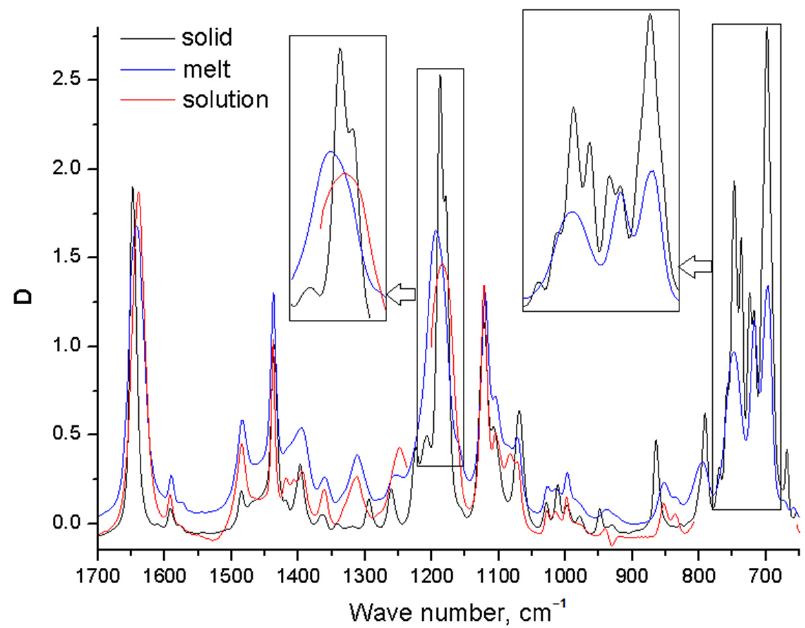
Figure 5. IR spectra of compound 1 in different aggregate states. D is the absorbance.